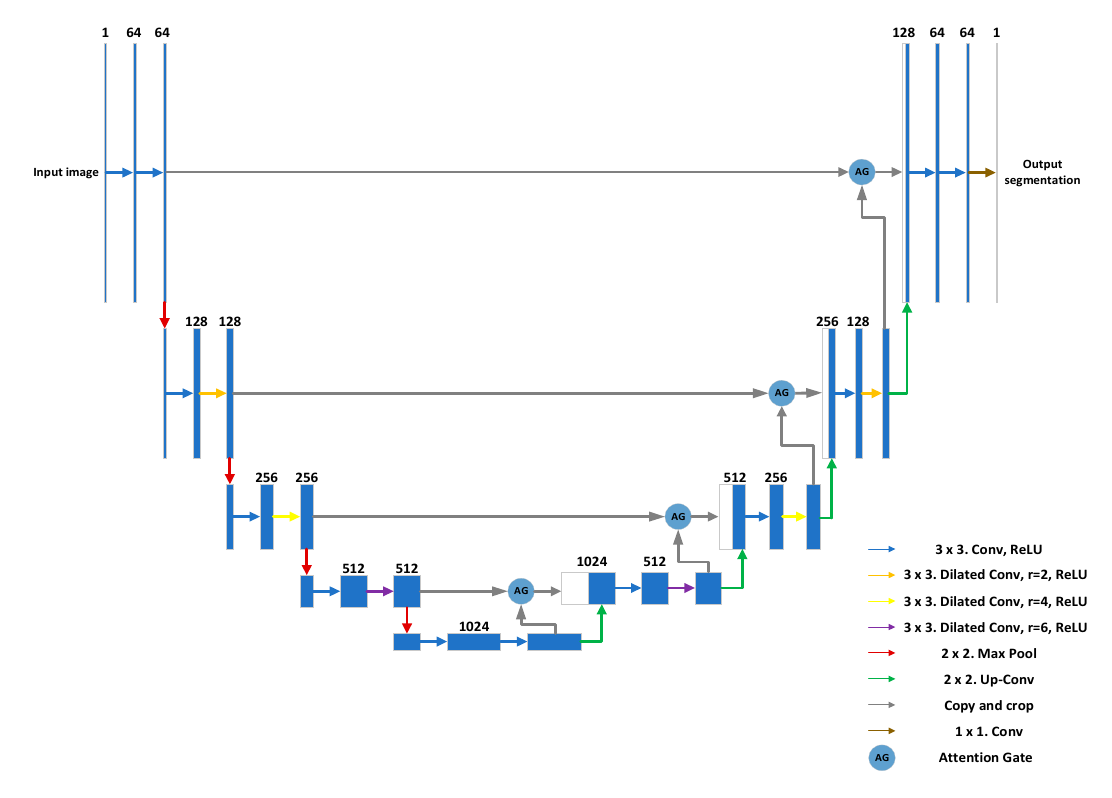
Figure 9. Structure of the improved U-Net.